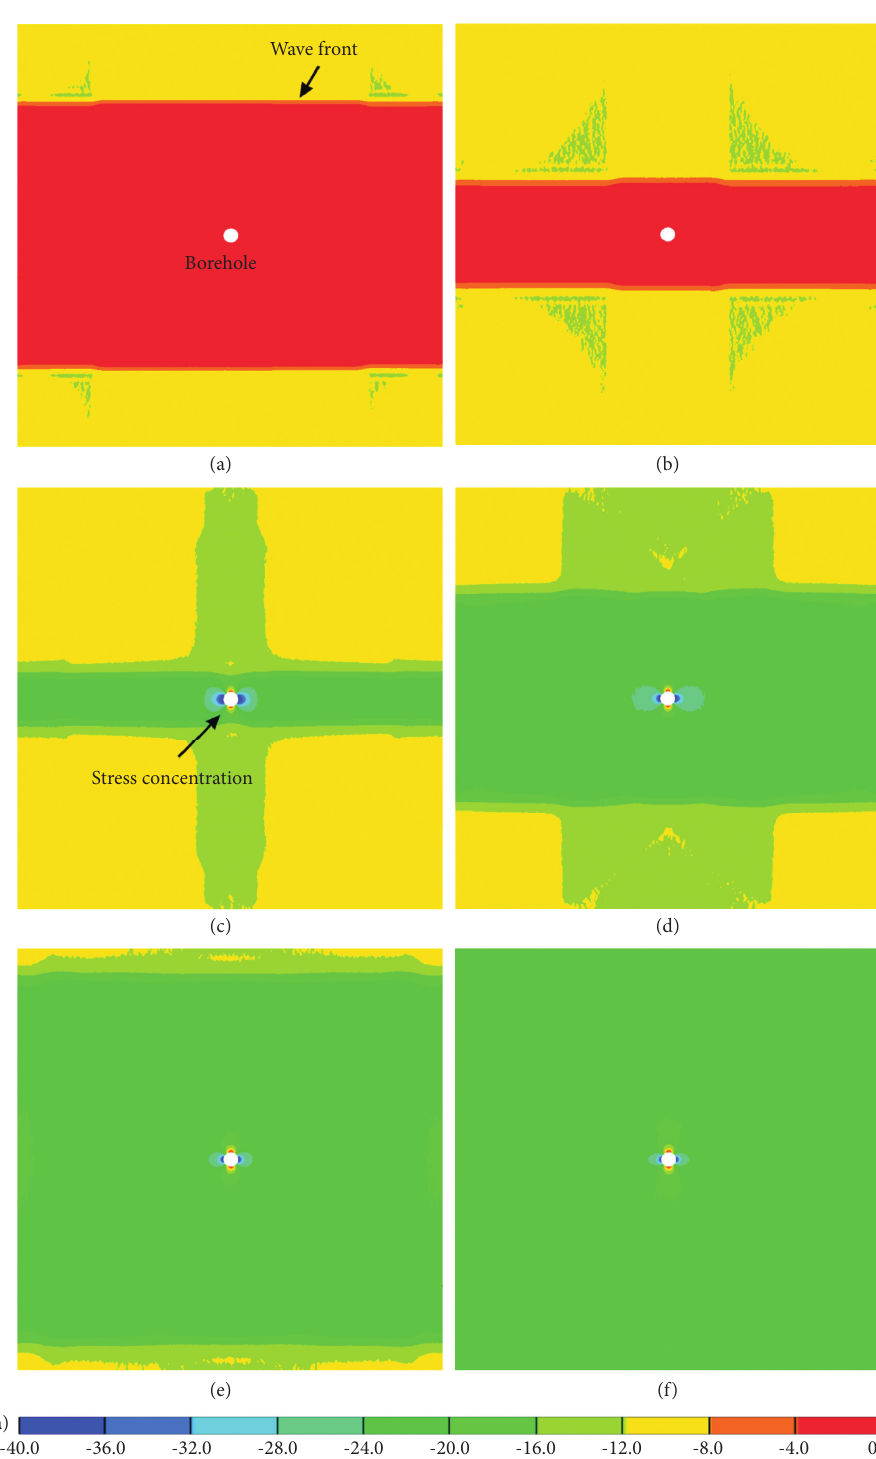
� 8.27 μ s. (b) t � 16.57 μ s. (c) t � 24.87 μ s.